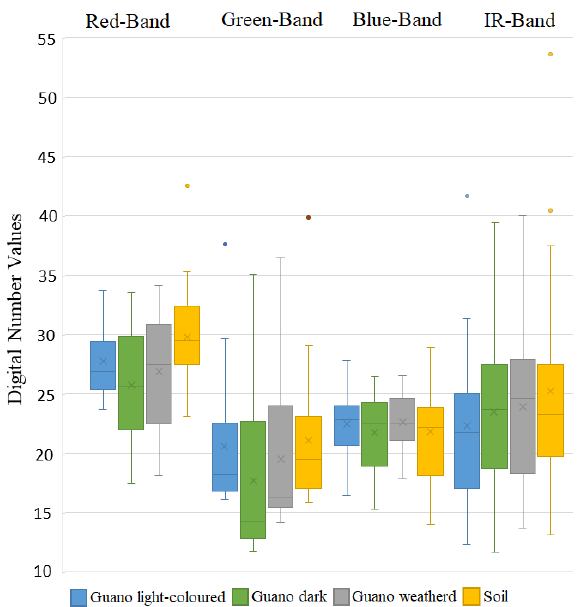
Figure 4. Spectral properties of different ground covers on Ardley Island. IR-Band only available in satellite images. Plot shows outliers (points), min. and max. without outliers (whiskers), quartils (box), median (line in box) and mean (mark in box).